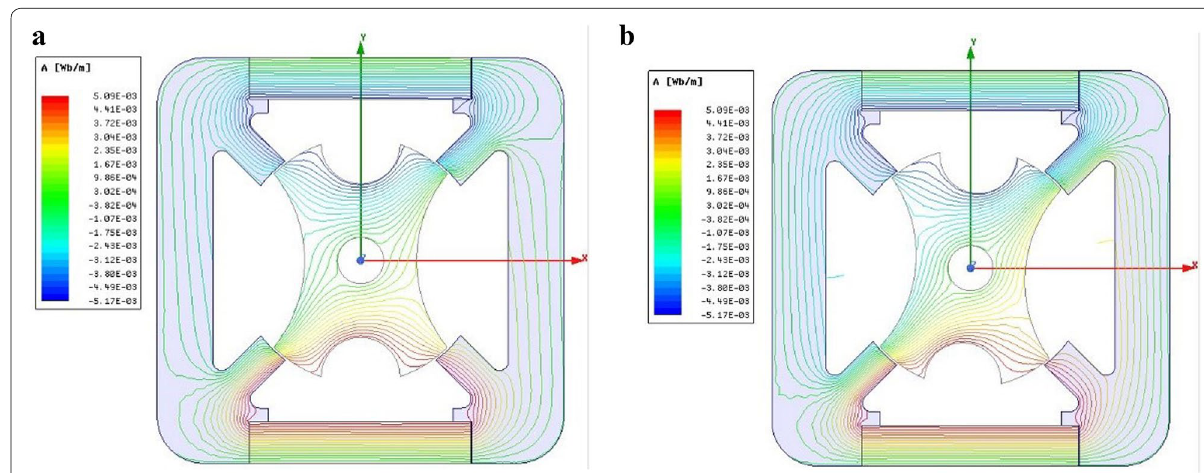
Figure 8 Magnetic flux of